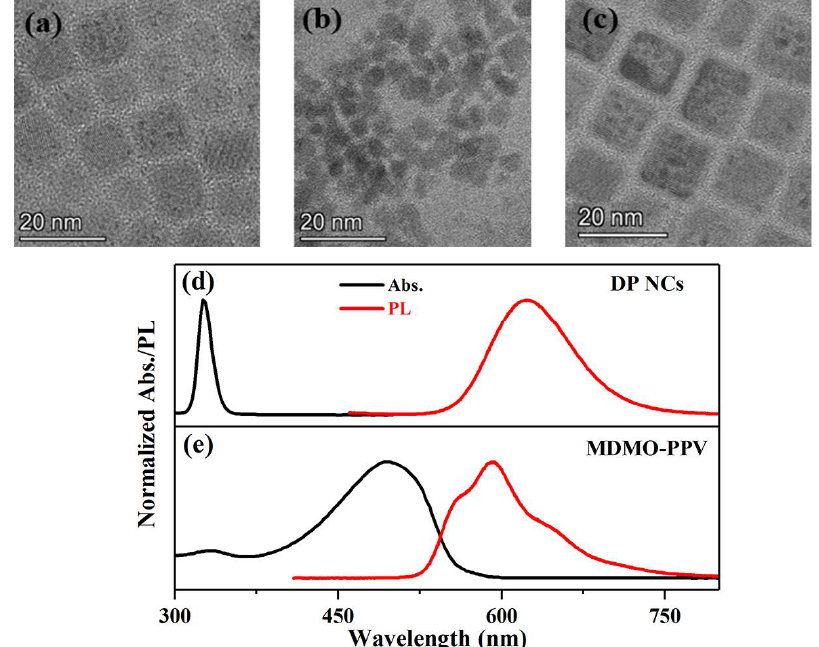
Figure 1. TEM images of ( a ) Mn-doped DP NCs, ( b ) MDMO-PPV polymers, and ( c ) DP NCs/MDMO-PPV nanocomposites. Normalized absorption (black line) and PL emission (red line) spectra of ( d ) Mn-doped DP NCs and ( e ) MDMO-PPV polymers in